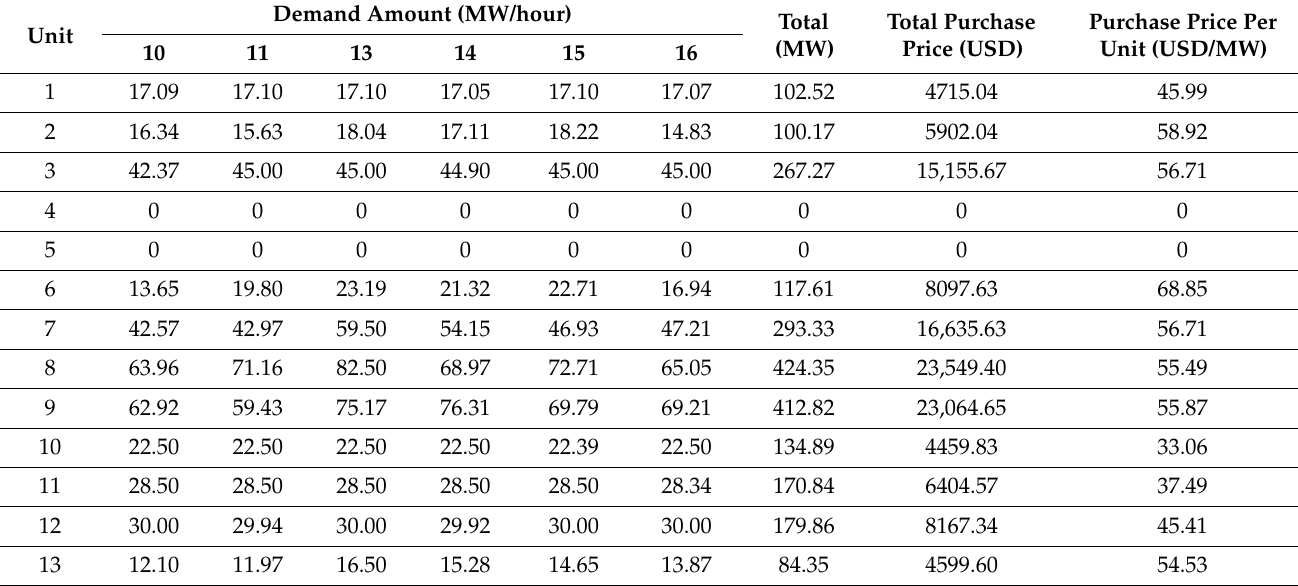
Table 5. Bidding demand amount and price in Case